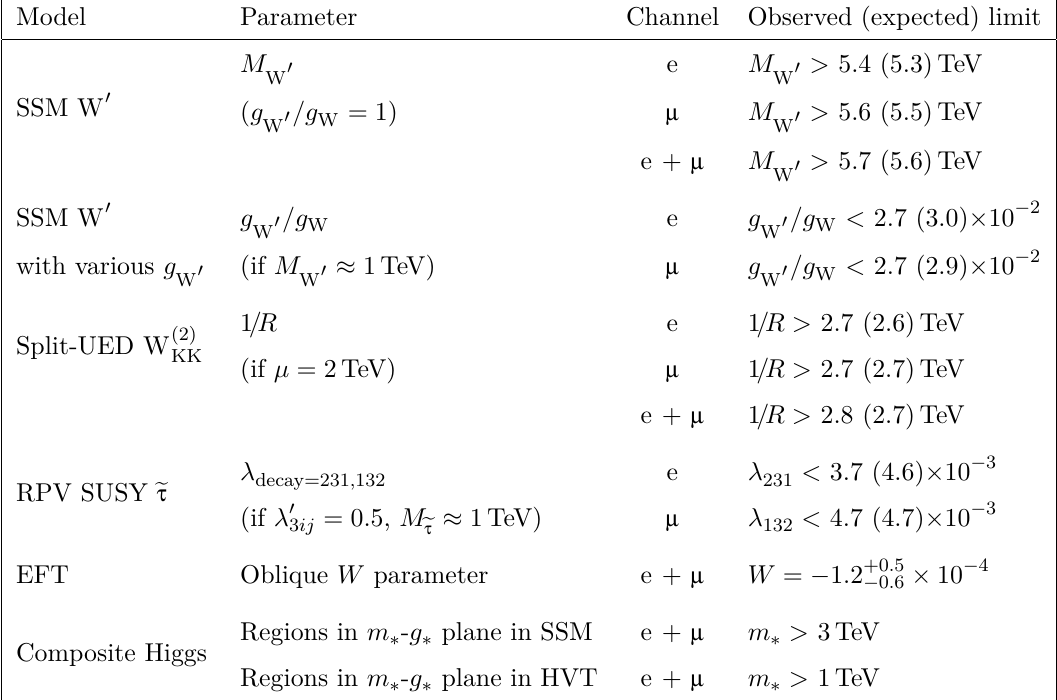
Table 3 . Summary of all 95% CL exclusion limit results with various theoretical model interpre- tations in the electron and muon channels, and the combination of both channels. The results in EFT and the composite Higgs boson model are obtained using 2017–2018 data sets only. The final allowed ranges for the model parameters are in the last column, except for the oblique W parameter, where a measurement is provided, and the Composite Higgs scenario, as explained in the